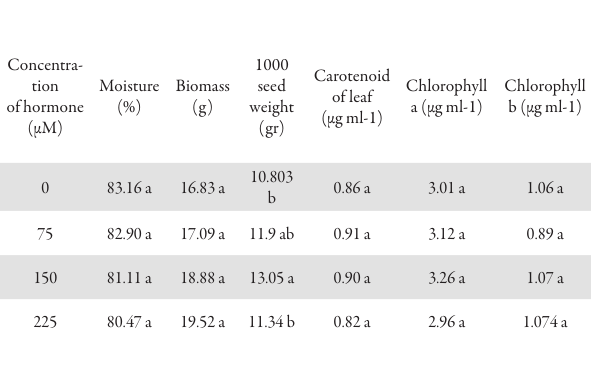
Tab. 1. Means comparison of studied attributes in treatment with jasmonic